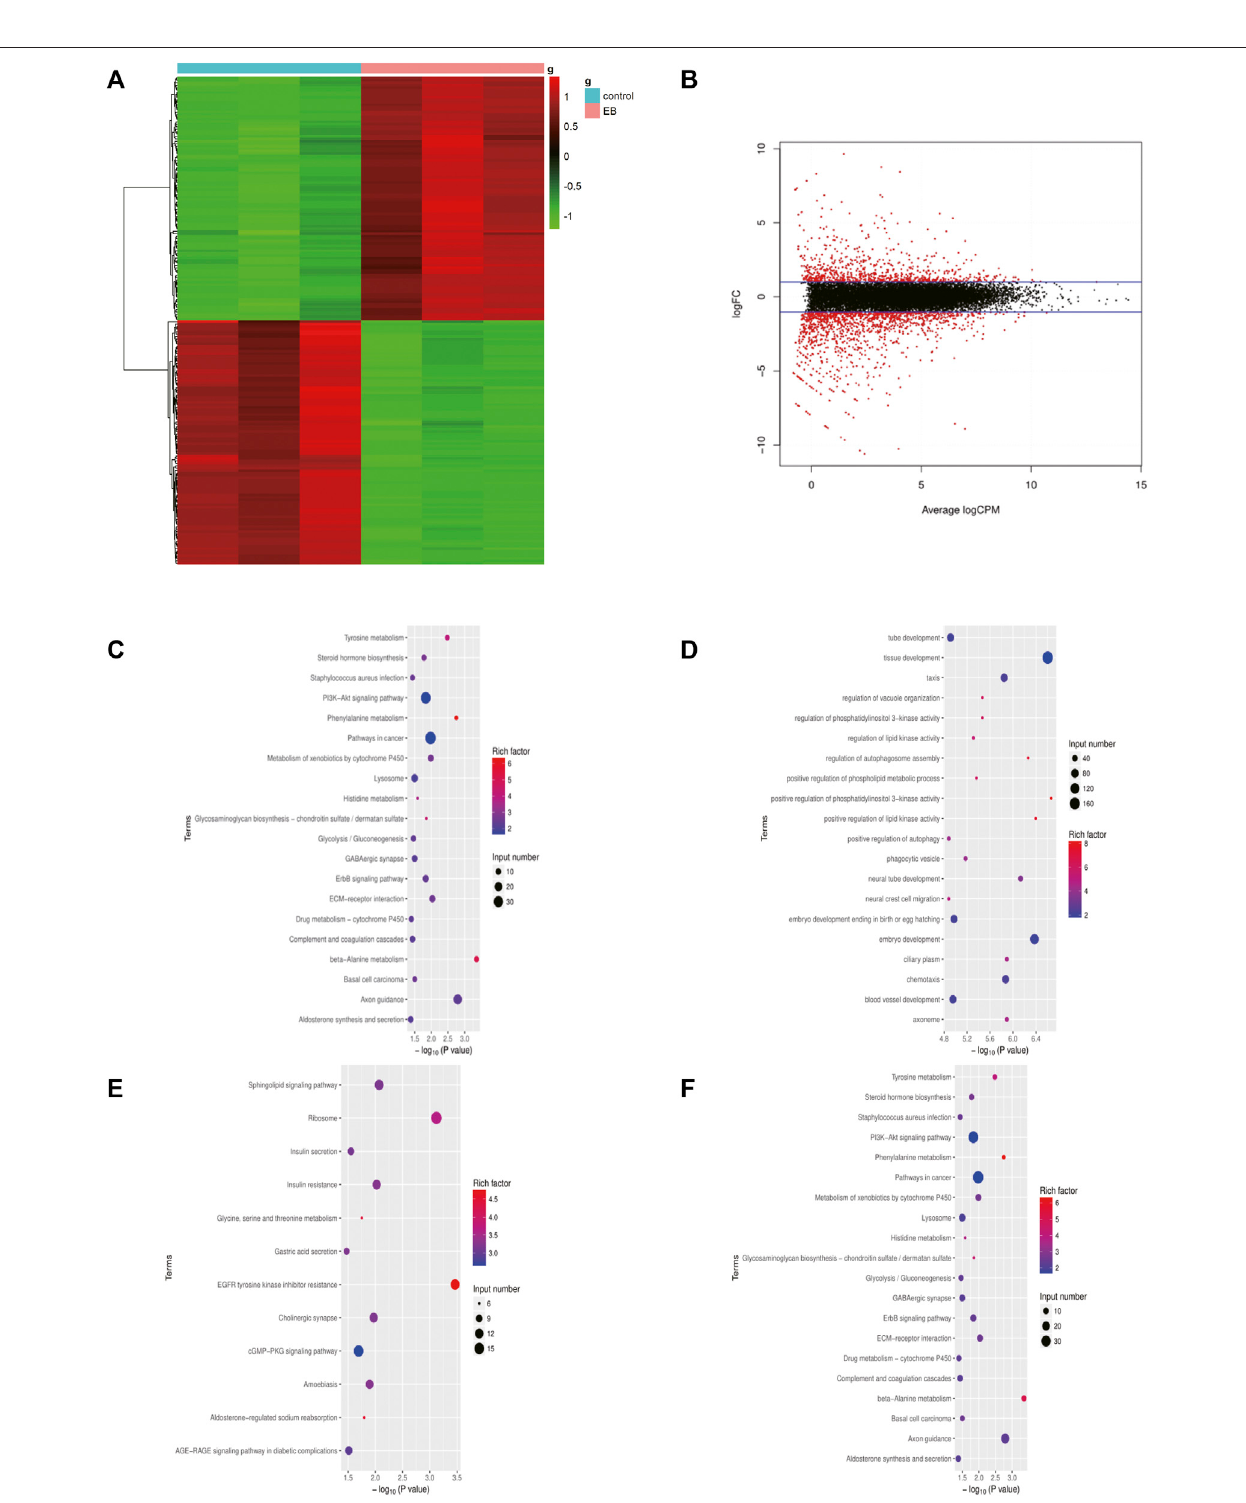
FIGURE 1 | DEGs identi fi ed in the EB-treated NCM460 cell line. (A) Heatmap of the top 200 DEGs by |logFC|. The color from blue to red indicates low to high expressionlevel. (B) VolcanomapbetweenEB-treatedandcontrolgroupsoftheNCM460cellline. (C,D) EnrichedtermsinGOanalysisofDEGsinEB-treatedNCM460, respectively. (E,F) Enriched terms in KEGG analysis of DEGs in EB-treated NCM460 DEGs, respectively; DEGS means differentially expressed genes; logFC means log fold change.